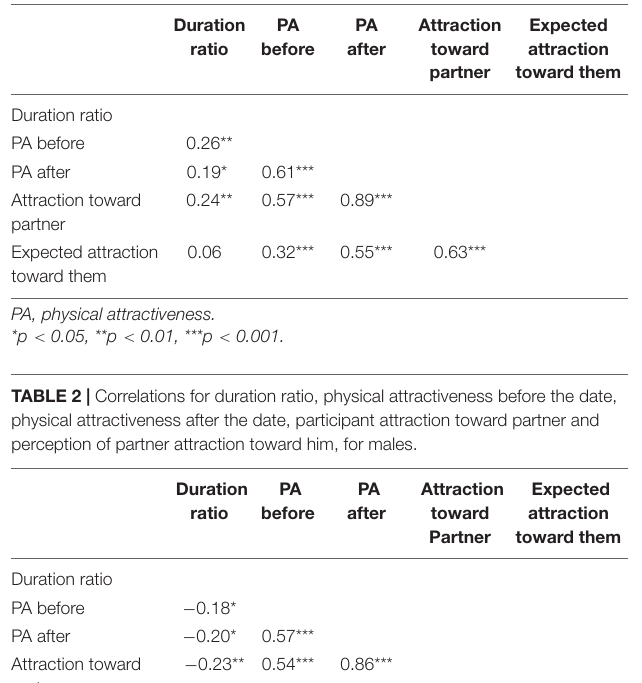
TABLE 1 | Correlations for duration ratio, physical attractiveness before the date, physical attractiveness after the date, participant attraction toward partner and perception of partner attraction toward her, for females.